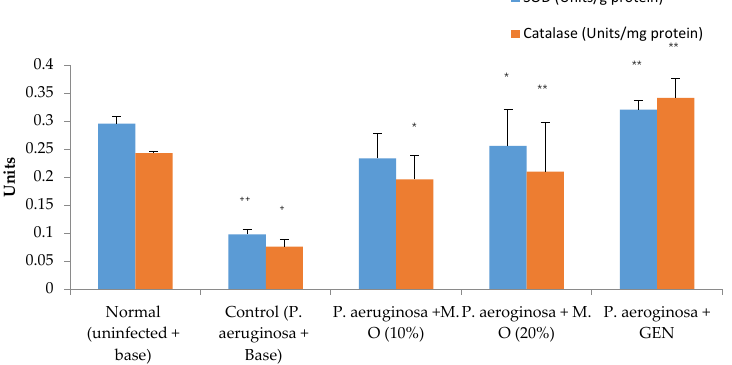
Figure 9. Effect on antioxidant enzymes in P. aeruginosa -infected diabetic animals. All values are mean ± SEM, n = 6, + p < 0.05, ++ p < 0.01 when compared to normal (uninfected). * p < 0.05, ** p < 0. 01 when compared to control (infected). M.O = M. oleifera leaf extractformulation, GEN = gentamicin (0.1% w / w ).